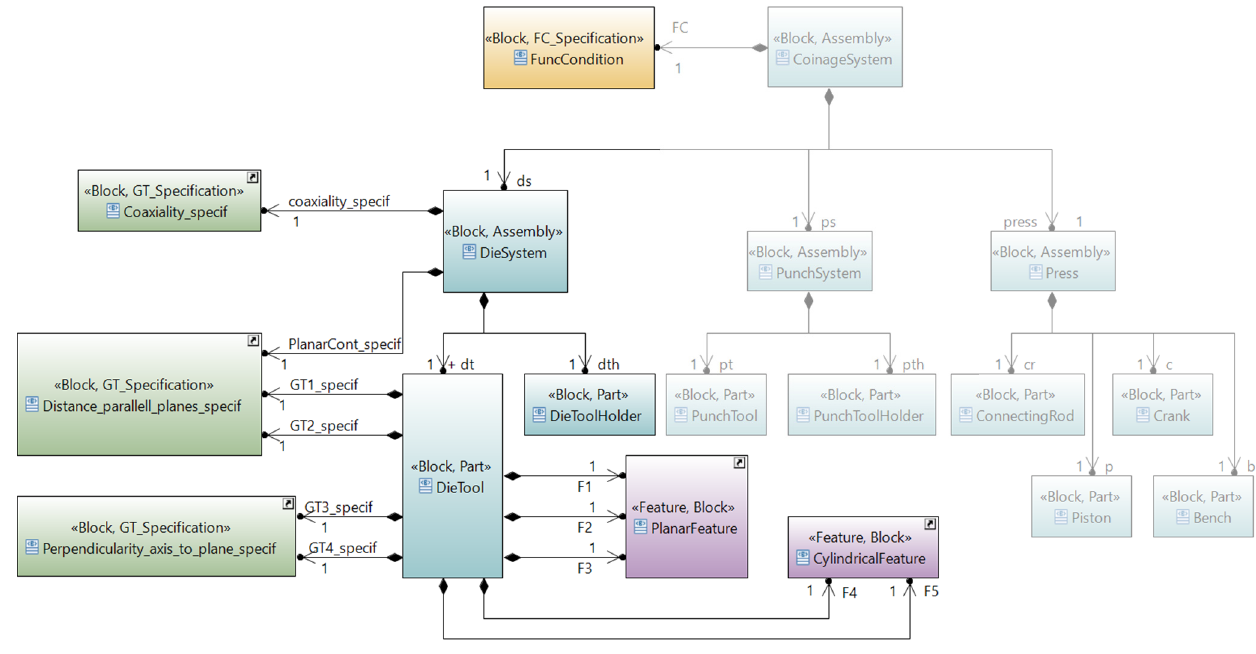
Figure 14. BDD to represent the Artifact structure of the CoinageSystem Block, focused on the elements that participate in the analysis model in next steps.